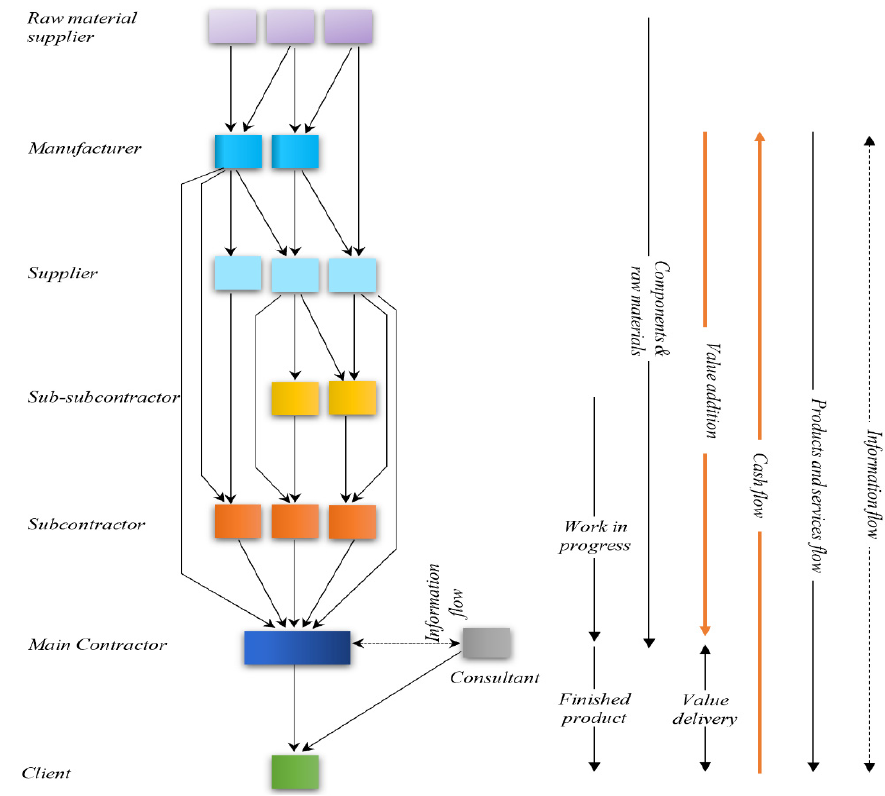
Figure 1. Basic supply chain network of the construction industry.